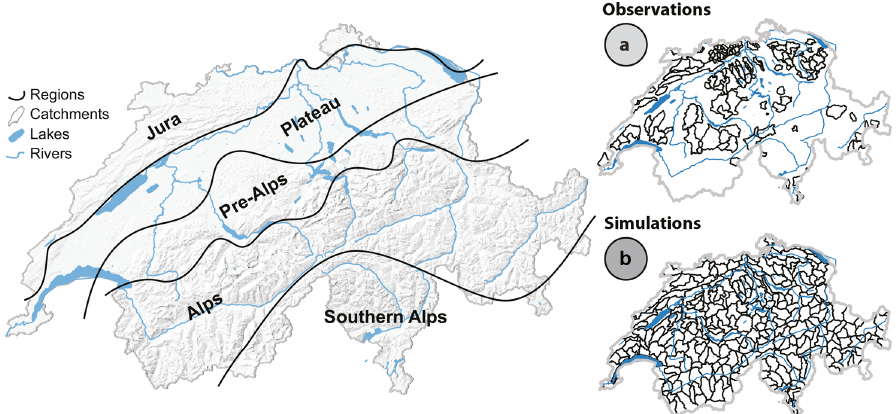
Figure 1. Switzerland and its topographical regions: Jura, Swiss Plateau, Swiss Prealps, Alps, and southern Switzerland. (a) Dataset consist- ing of catchments with observed hydro-meteorological variables. (b) Dataset consisting of catchments with simulated hydro-meteorological variables.